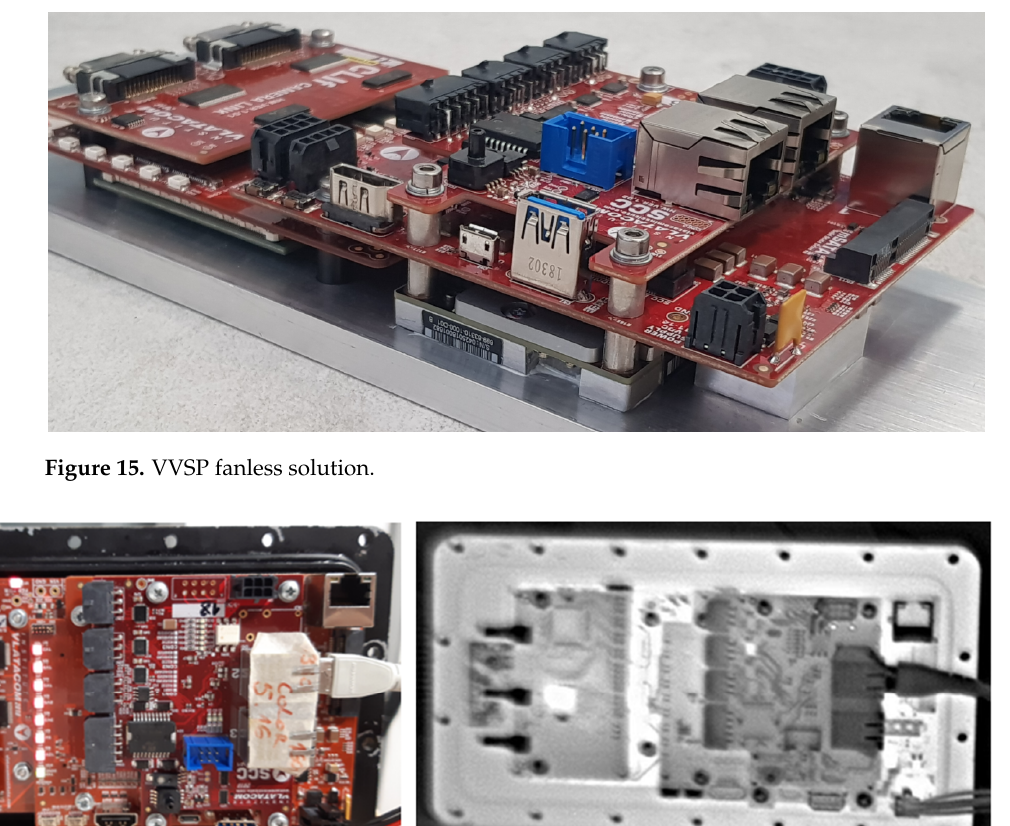
Figure 14. VVSP module during development stage .